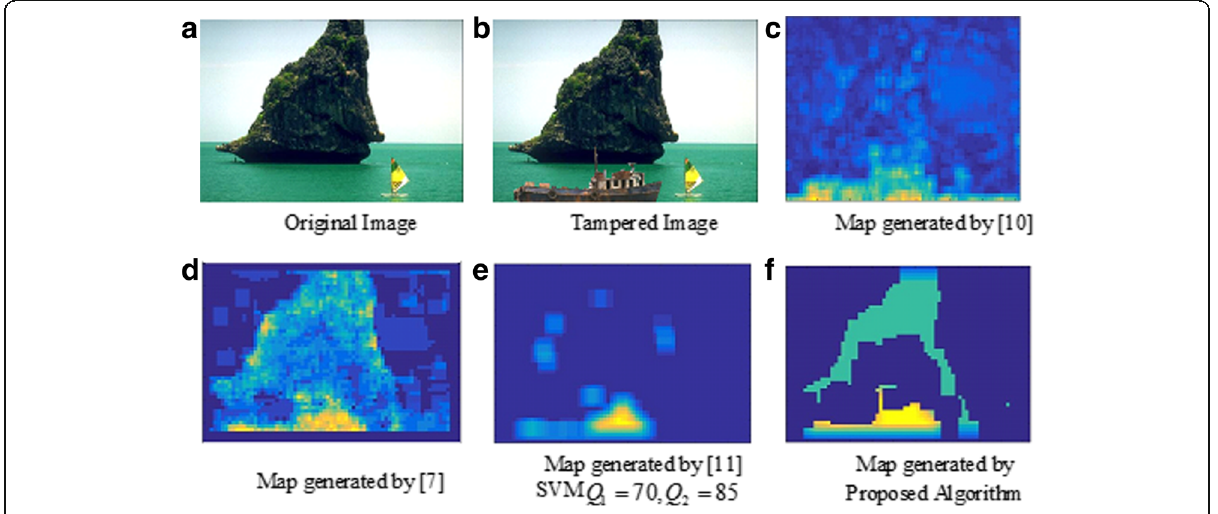
Fig. 4 a – f Tampering localization natural image, CASIA V.2